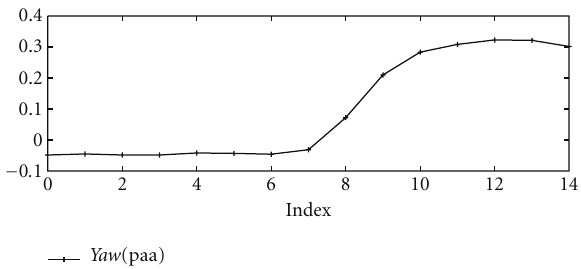
Figure 10: Example of frame number reduction.